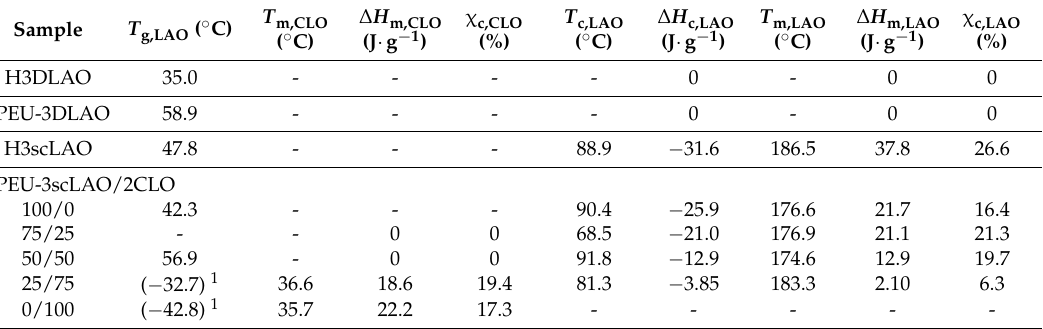
Table 2. Data collected from the second heating DSC curves of H3DLAO, PEU-3DLAO, H3scLAO